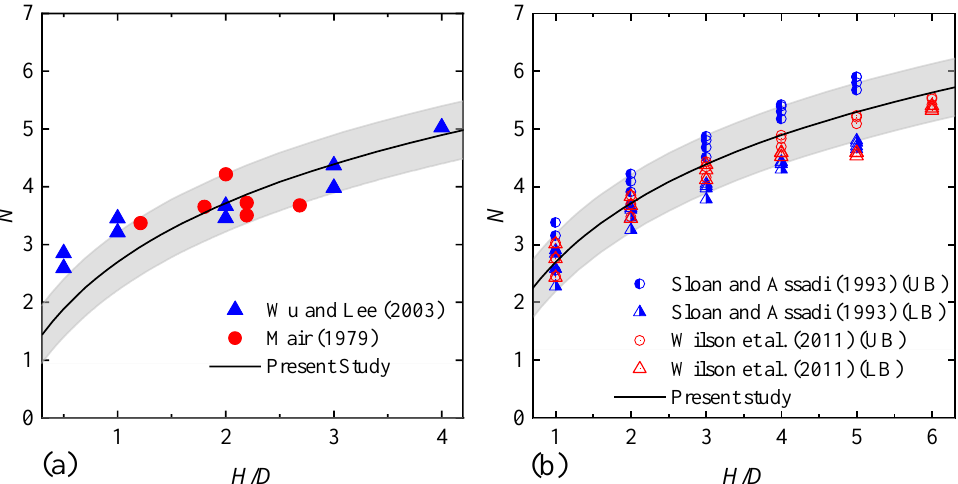
Figure 3. Comparison of predicted stability numbers with 2D centrifuge model tests and FELA results: ( a ) model tests; ( b ) FELA results.